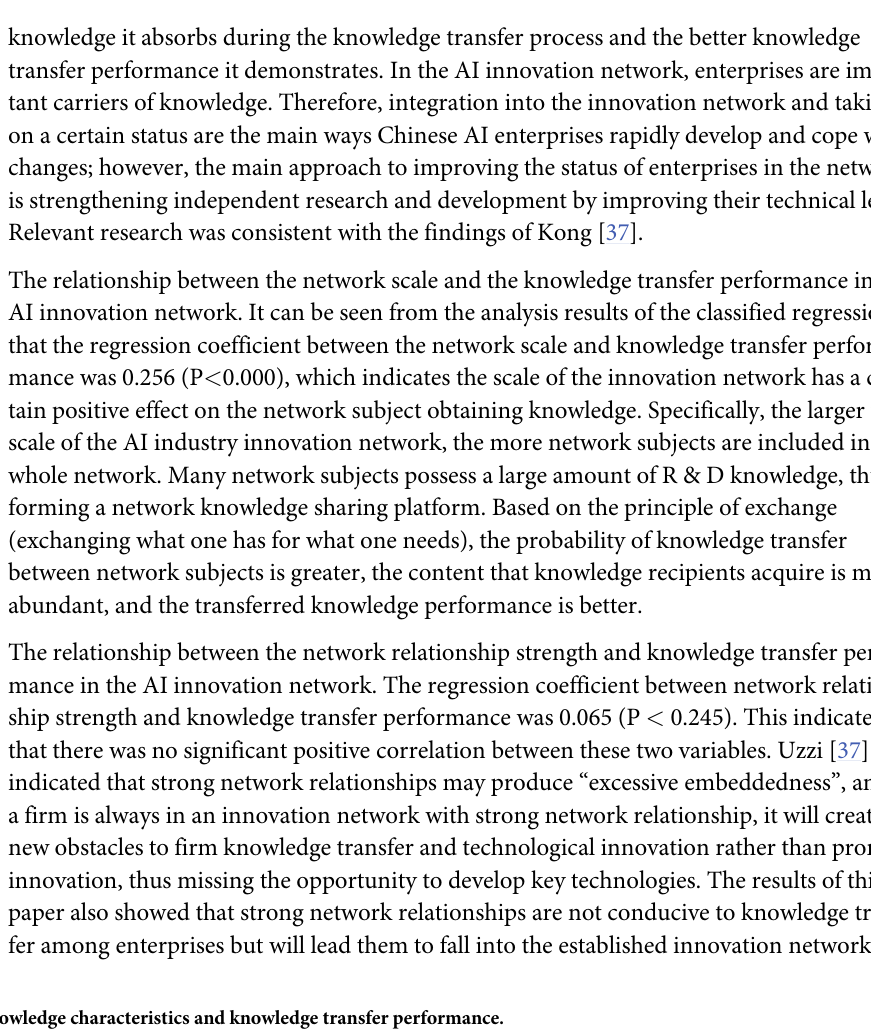
Table 14. Classified regression analysis results of knowledge characteristics and knowledge transfer performance.